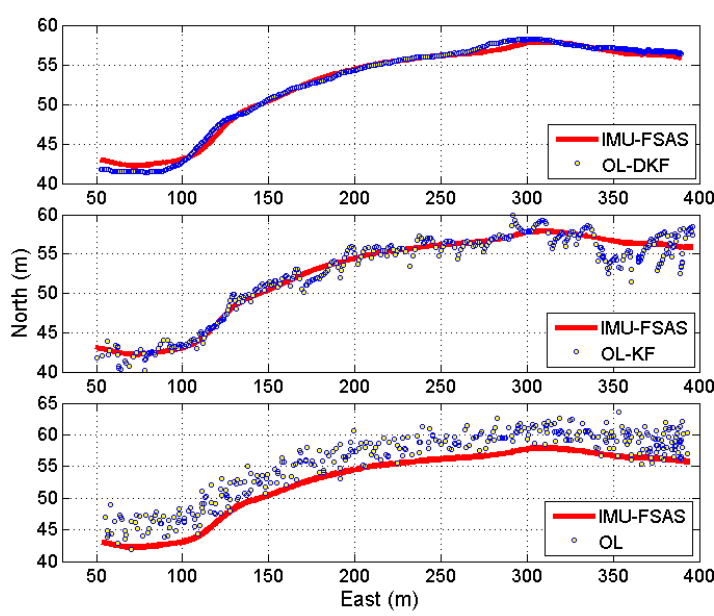
Figure 16. Trajectories of open loop with a differential Kalman filter (OL-DKF), open loop tracking aided by the Kalman filter (OL-KF), open loop tracking (OL) and IMU-FSAS of the unblocked road test.